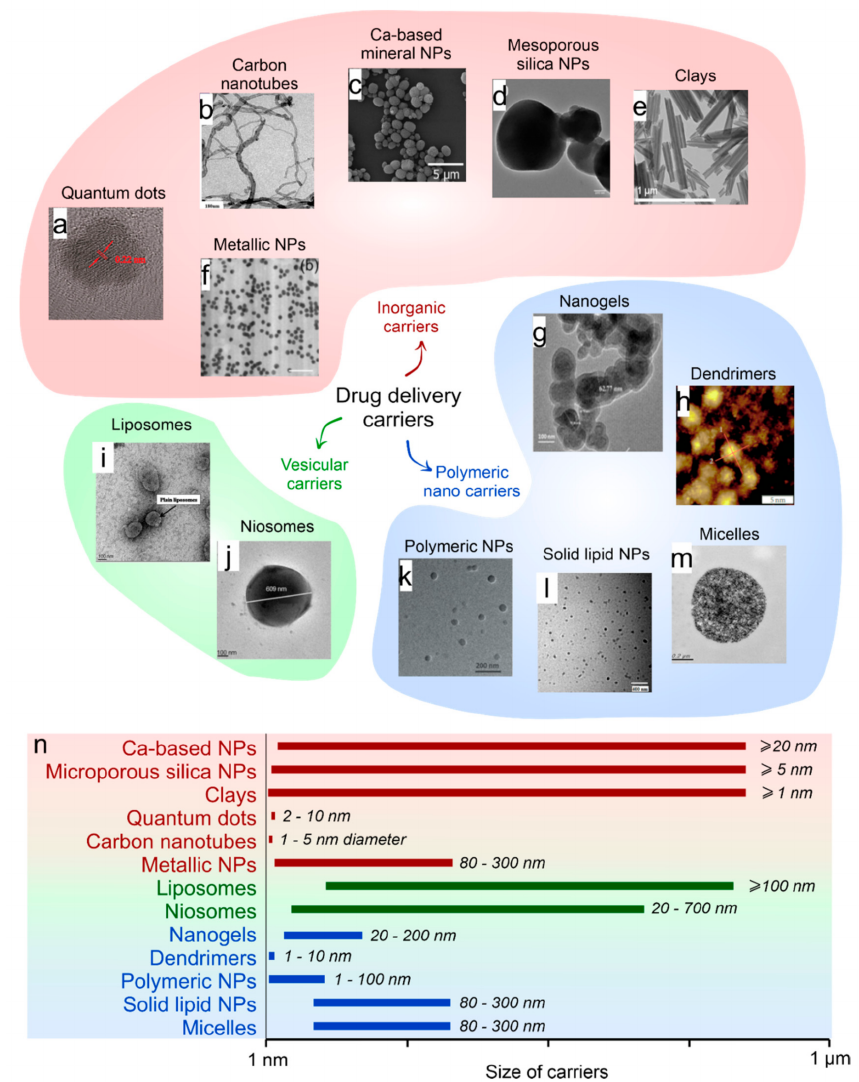
Figure 1. ( a ) Classification of the most commonly used nanocarriers for drug delivery ( a – m ) with included photos of the quantum dots (SEM image reprinted with permission from Frontiers